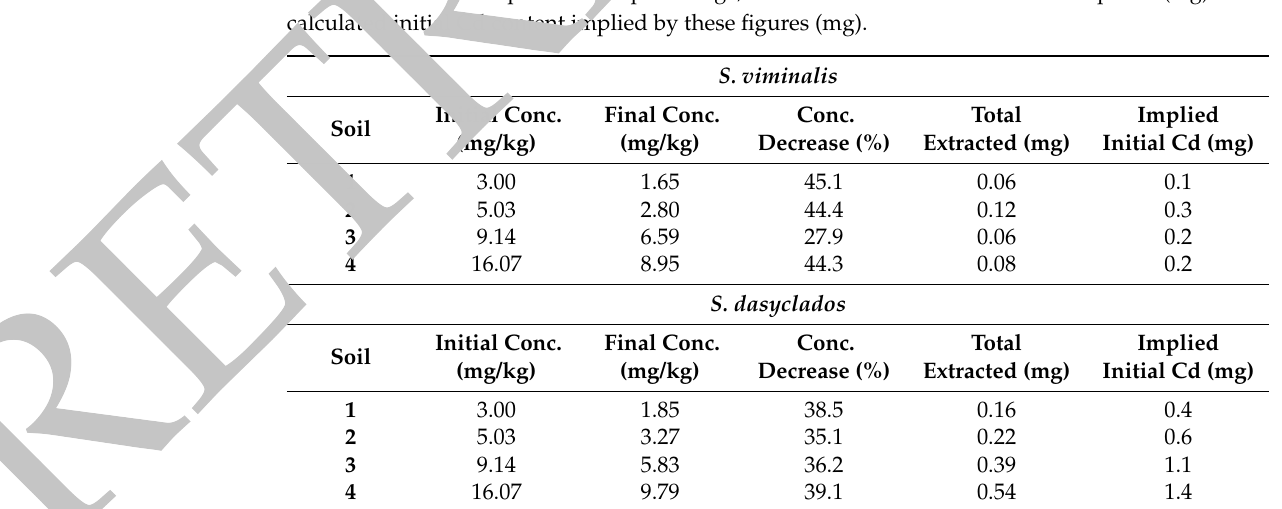
Figure 6. Total amounts by mass of Cd extracted by harvestable plant fractions with total values shown for each set of three plants of each species grown in each soil. Table 13. Soil Cd concentrations (mg/kg). Initial and final values given for each soil along with drop in Cd concentration expressed as a percentage, total extraction for each set of three plants (mg) and a calculated initial Cd content implied by these figures